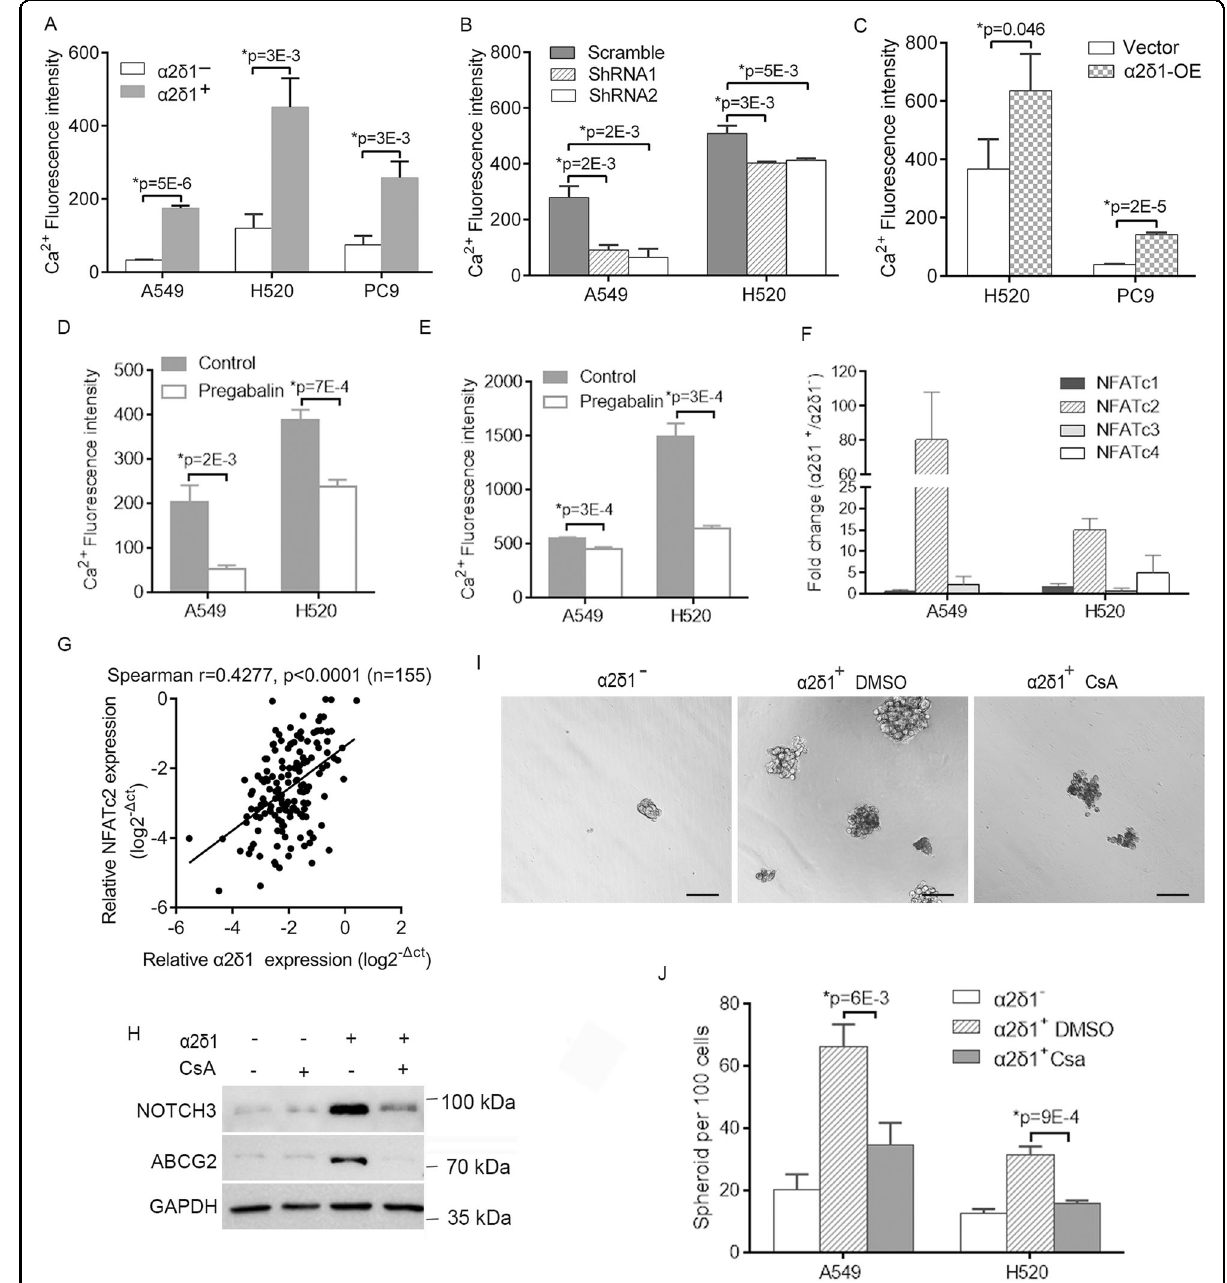
Fig. 6 Ca 2 + /NFATc2 is responsible for α 2 δ 1-mediated TIC properties. A – C The [Ca 2 + ] i levels were detected by fl ow cytometry using Ca 2 + probe Fluo-4/AM in sorted α 2 δ 1 + and α 2 δ 1 − fractions from indicated cell lines ( A ), α 2 δ 1 + cells from indicated sources with α 2 δ 1 knockdown by shRNAs ( B ), and the indicated cells overexpressing α 2 δ 1 ( C ). D , E The [Ca 2 + ] i levels were measured by fl ow cytometry in α 2 δ 1 + A549 and H520 subpopulations ( D ), as well as in A549 and H520 cells overexpressing α 2 δ 1 ( E ) following treatment with pregabalin at 10 μ mol/L for 24 h. F The expression of NFATc1-4 was measured in sorted α 2 δ 1 + and α 2 δ 1 − subsets from indicated sources by qRT-PCR. G The relationship between the expression of α 2 δ 1 with NFATc2 mRNA in clinical samples of NSCLC as detected by qRT-PCR. ( H ) Western blot results demonstrating the effects of cyclosporinA (CsA) on the expression of NOTCH3 and ABCG2 in sorted α 2 δ 1 + and α 2 δ 1 − subpopulations of A549 cells. GAPDH is an internal loading control. I Representative phase-contrast micrographs showing the effects of CsA on the sphere-forming ability of the α 2 δ 1 + A549 cells. Scale bar, 100 µm. J Histograms showing the sphere-forming ef fi ciencies of the α 2 δ 1 + fractions from indicated cell lines treated with DMSO or CsA (1 µmol/L) ( n = 3). All error bars represent SD of three independent experiments. *Student ’ s t -test.